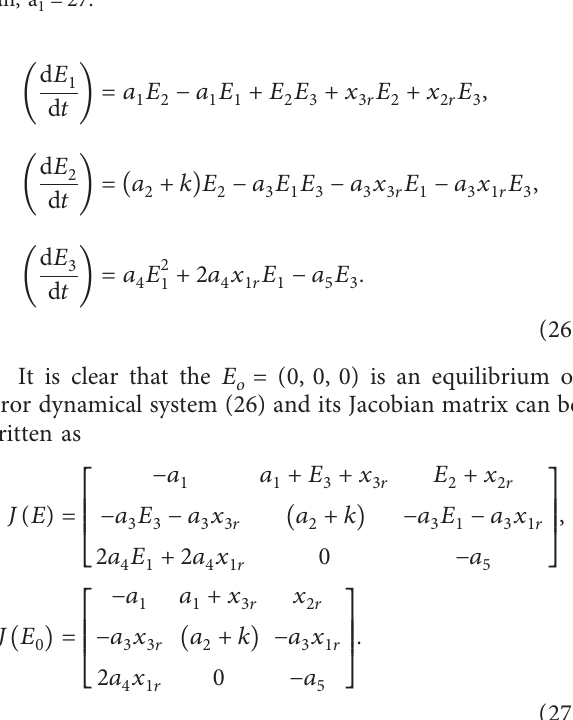
( t ) ,x ( t )) plan, a 1 3